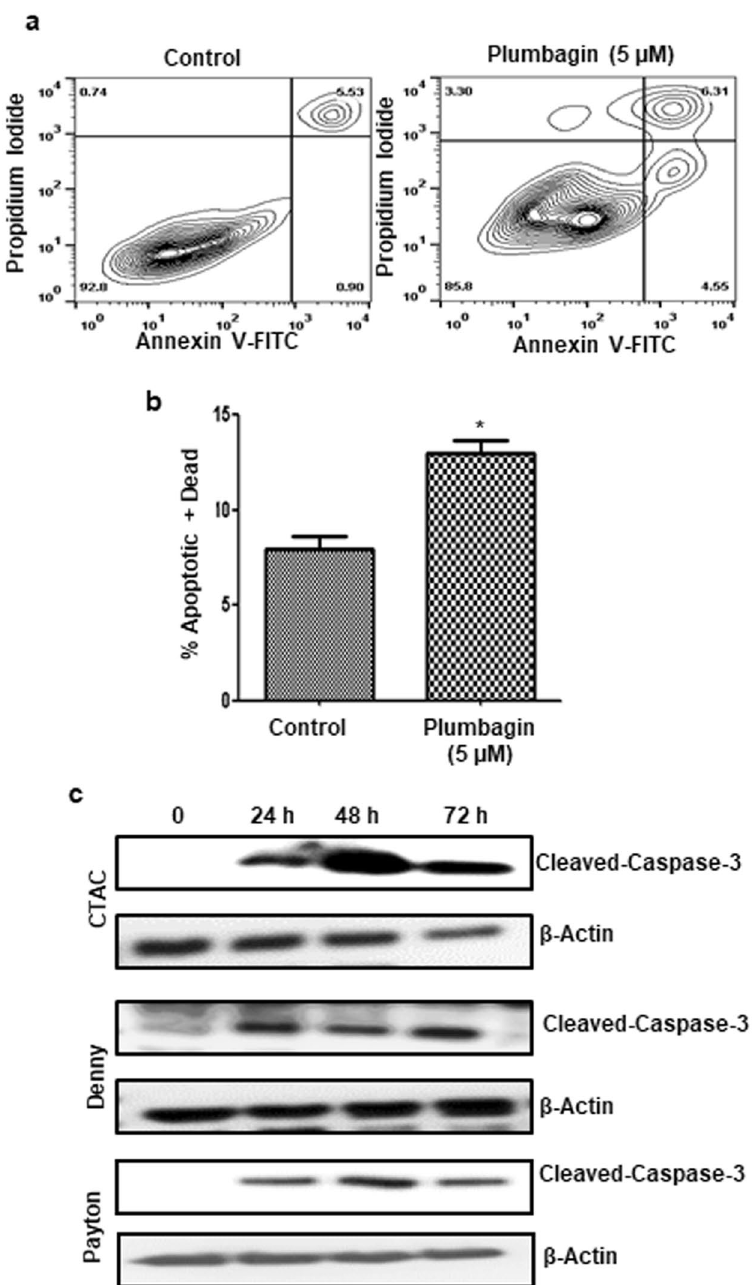
Figure 2. Plumbagin induces apoptosis in canine cancer cells. ( a) CTAC cells were treated with plumbagin (5 μ M) for 24 h. Following treatment, the cells were stained with Annexin V-FITC (to detect expression of phosphatidylserine on the surface of the cell) and propidium iodide (as a live/dead cell indicator) and the cells were analyzed by analytical flow cytometry. ( b) The bar chart shows average data from three independent replicates for the annexin V-FITC/propidium iodide assays. ( * p = 0.006). ( c) Three canine cancer cell lines CTAC, Denny and Payton were treated with plumbagin (5 μ M) for the depicted time points. After treatment, the cells were lysed and expression of cleaved caspase 3 and β -actin (as a loading control) was determined by western blotting. The blots shown are representative of three independent replicates. Cropped blots showing cleaved caspase 3 and β - actin bands are shown. Full-length blots are provided in Supplementary Fig.